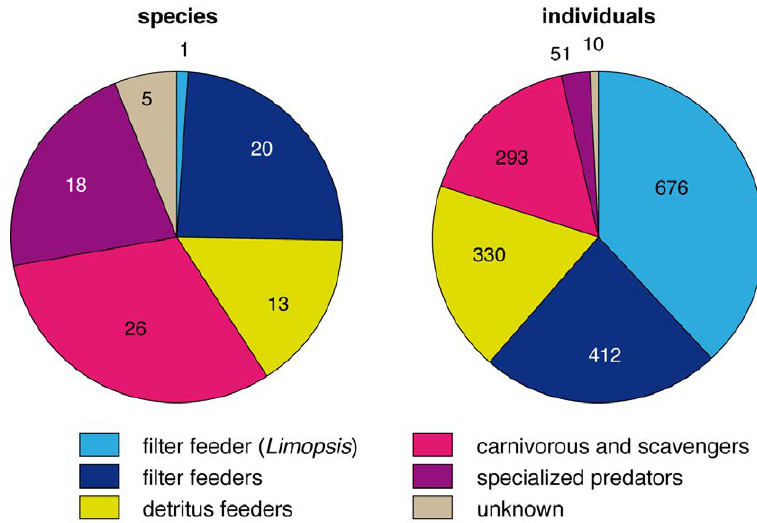
Fig. 10. – Distribution of molluscan species and of individuals by feeding guilds, in haul